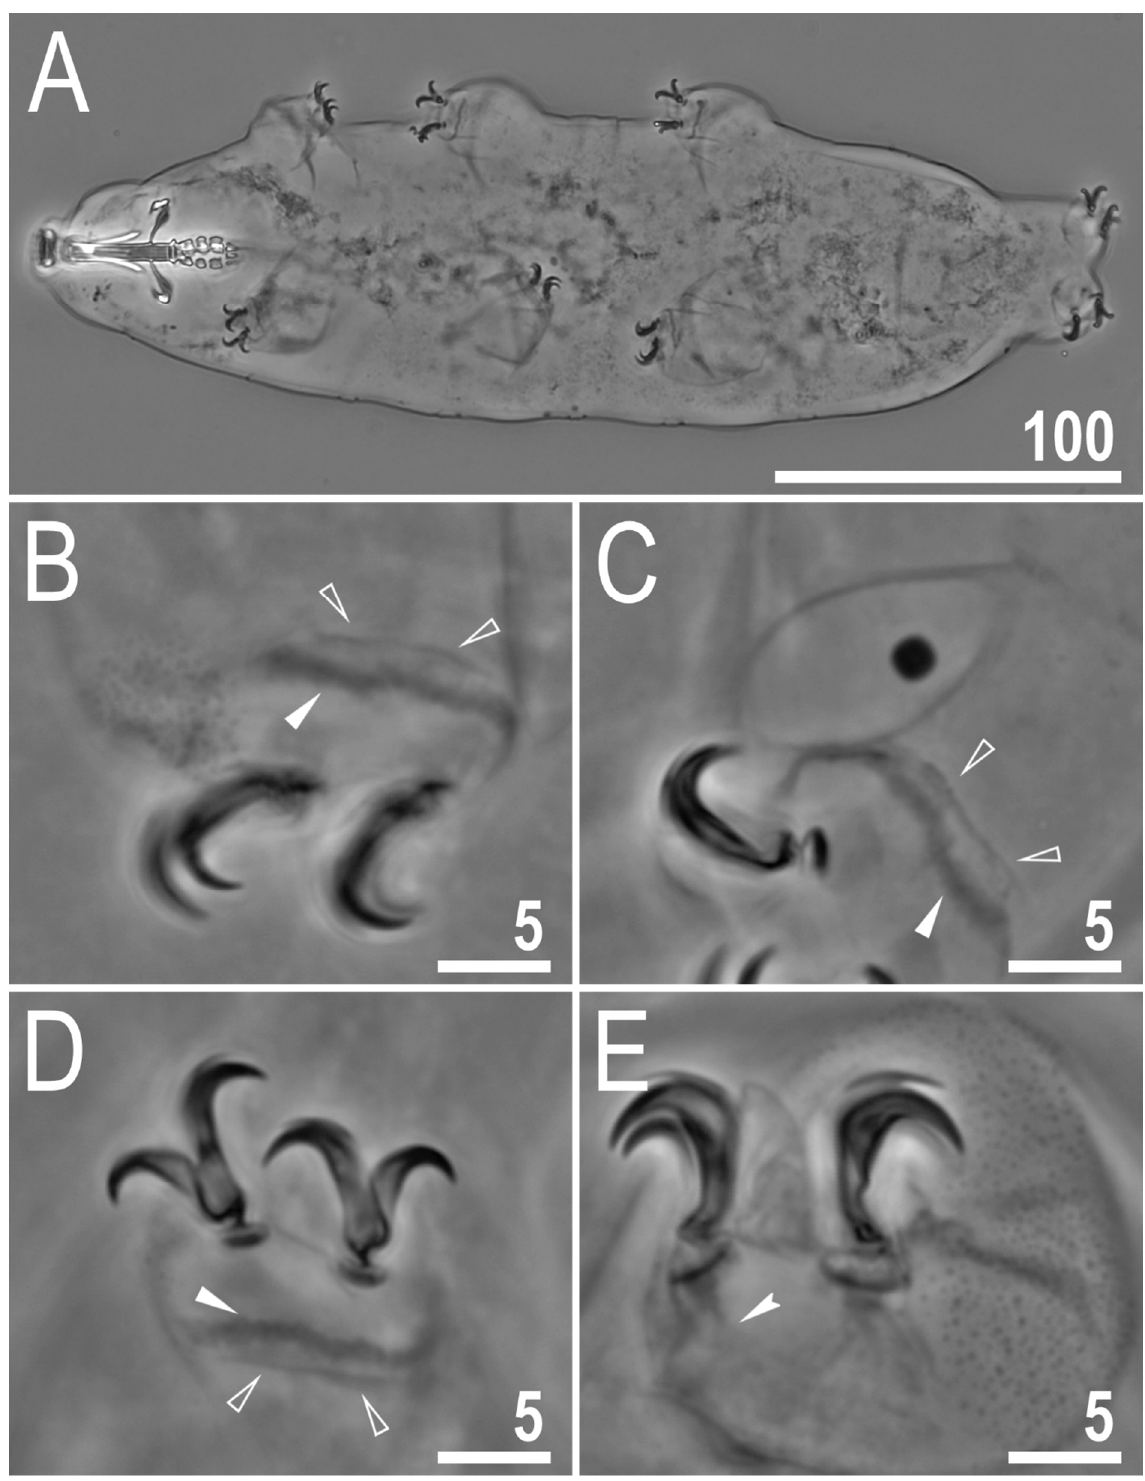
Figure 7. Mesobiotus marmoreus sp. nov. —PCM image of habitus and leg’s cuticle morphology and claws: ( A )—dorso-ventral projection (holotype); ( B )—granulation on the external surface of leg III (holotype); ( C )—a pulvinus-like cuticular bulge on the internal surface of leg II (paratype); ( D )—claws I with smooth lunulae (holotype); ( E )—granulation on dorsal and lateral surface and claws on leg IV (paratype). Filled flat arrowheads indicate a single continuous cuticular bar above the claws, empty flat arrowheads indicate paired muscles attachments, filled indented arrowhead indicates horseshoe structure connecting the anterior and the posterior claw. Scale bars in μ m.